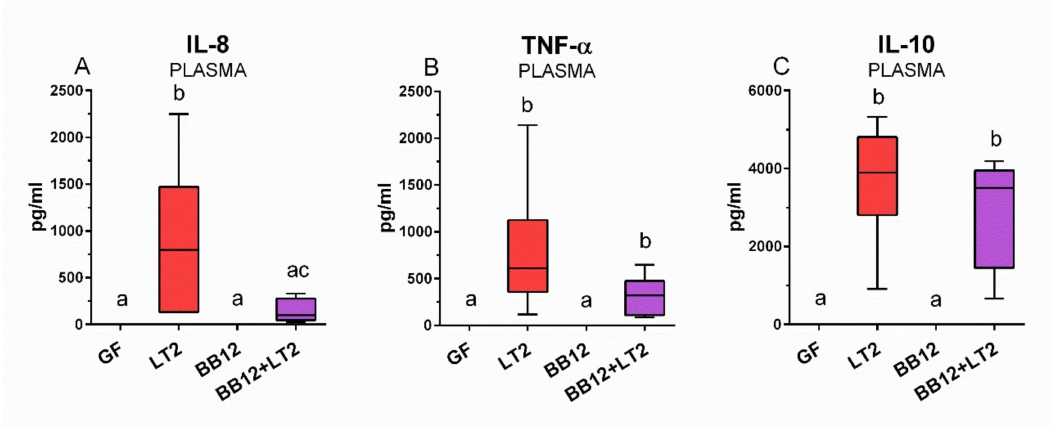
Figure 7. Plasmatic levels of the inflammatory cytokines IL-8 ( A ), TNF- α ( B ) and IL-10 ( C ) in the gnotobiotic piglets: germ-free (GF), infected with S . Typhimurium LT2 for 24 h (LT2), associated with B. animalis subsp. lactis BB12 (BB12), and associated with BB12 and infected with LT2 for 24 h (BB12 + LT2). The values are presented as boxes indicating the lower and upper quartiles, the central line is the median, and the ends of the whiskers depict the minimal and maximal values. Statistical differences were calculated by the Kruskal–Wallis test with Dunn’s multiple comparison post hoc test, and p < 0.05 are denoted with different letters above the columns. Six samples in each group were